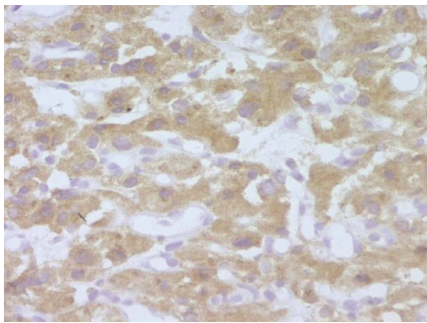
Figure 4: (Chromox400) strong and diffuse cytoplasmic